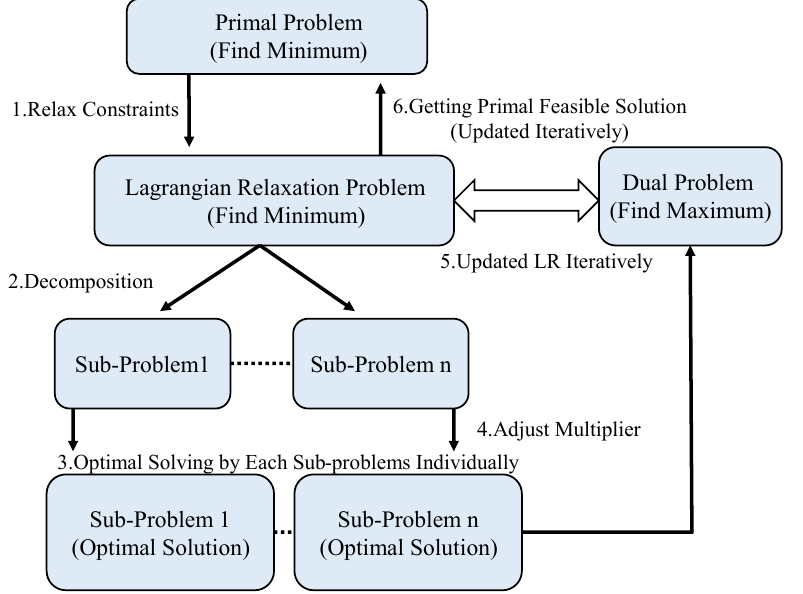
Figure 3. Procedure Flow Chart of Lagrangian Relaxation.